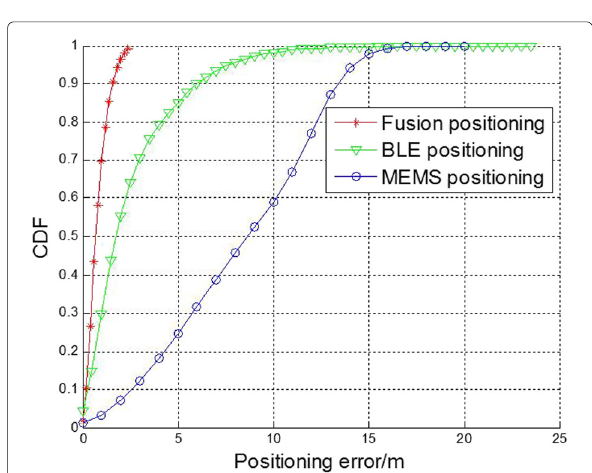
Fig. 33 Locations tracking under linearshape of trajectory